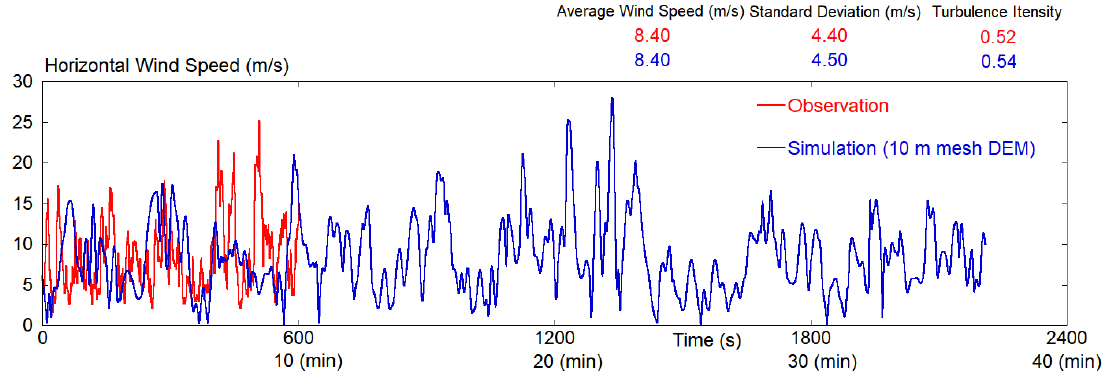
Figure 13. Comparison of horizontal wind speed between the observed data (red line) and the simulated data converted to full scale (blue line).